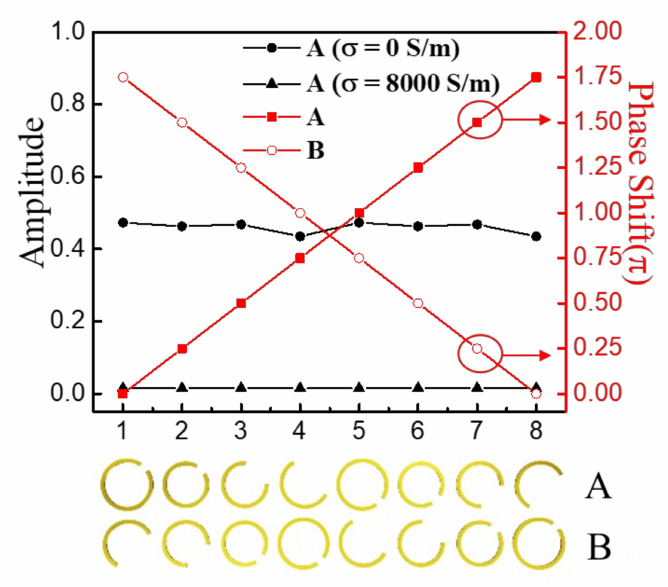
Figure 2. Transmission amplitudes and phases of eight SRRs in supercells A and B at 0.8 THz with the x -polarized terahertz incidence and y -polarized